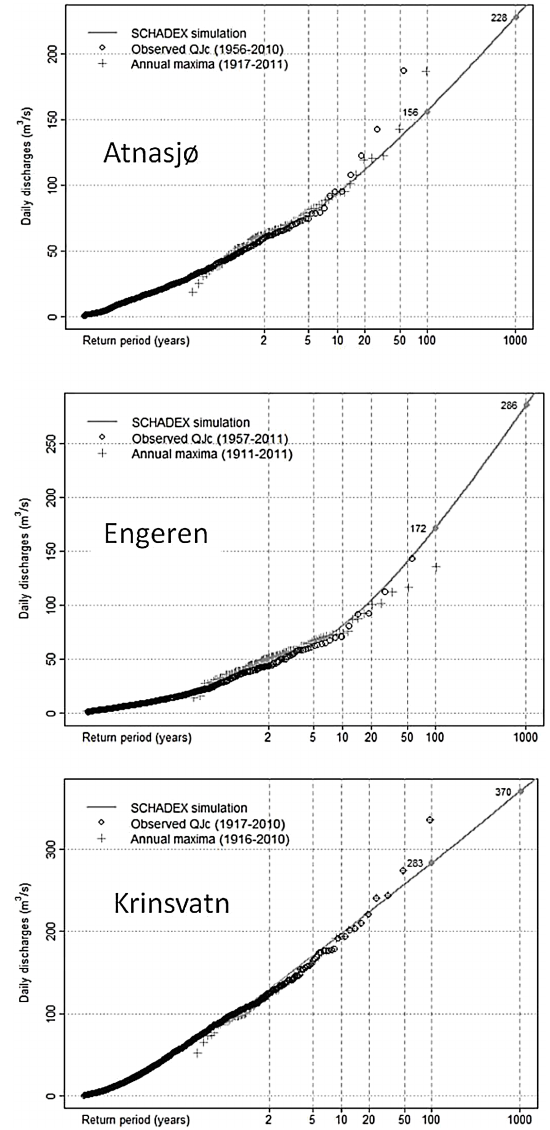
Figure 9. Distribution of daily discharge values based on SHADEX, as compared with the observed annual maxima and the observed discharges associated with centred rainfall events ( QJ c )